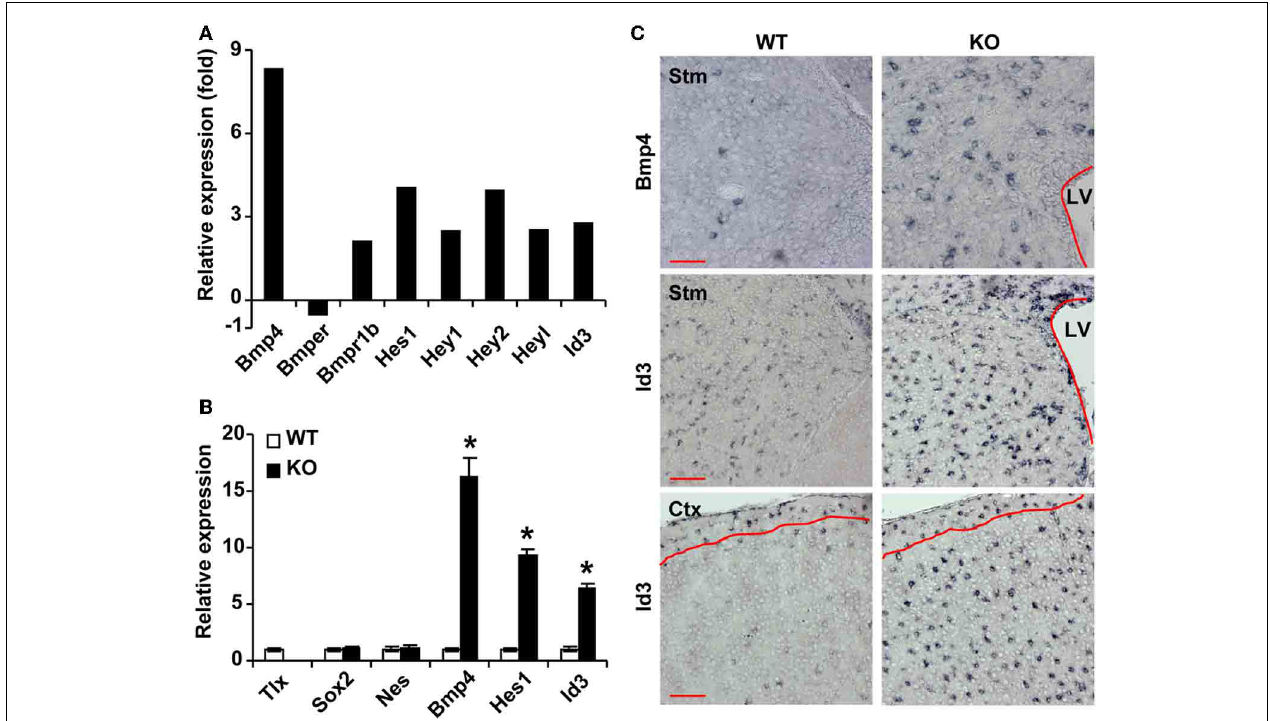
∗ P < 0 . 001 by Student’s t -test ( n = 3). (C) RNA in situ hybridization confirms expression of selected genes at P14. The lateral ventricles (LV) are outlined. Red lines mark layer I where the expression of Id3 is unchanged. Stm, striatum; Ctx, cortex. Scale: 100 μ m.